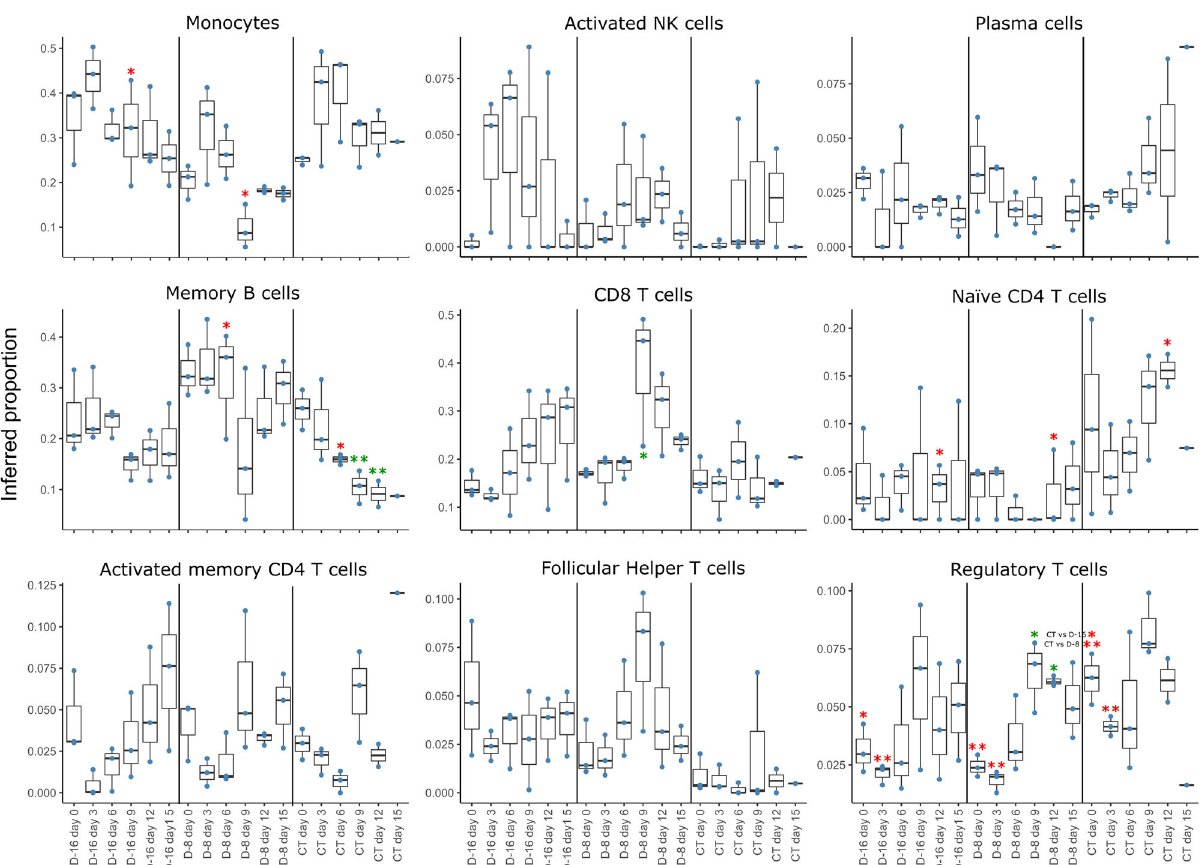
Fig.10|Evolutionofthecell-typecompositionestimatesinPBMCsamplesover time based on transcriptome data. Inferred proportion of monocytes, activated NK cells, plasma cells, memory B cells, CD8 + T cells, naive CD4 + T cells, activated memoryCD4 + T cells, follicular helper CD4 + T cells, and regulatoryT cellsin PBMC samples collected at various time points after the LASV infection (central line, median; limits, fi rst and third quartiles; whiskers, largest or smallest value no fur- ther than 1.5 times the interquartile range from the hinge). Blue dots represent